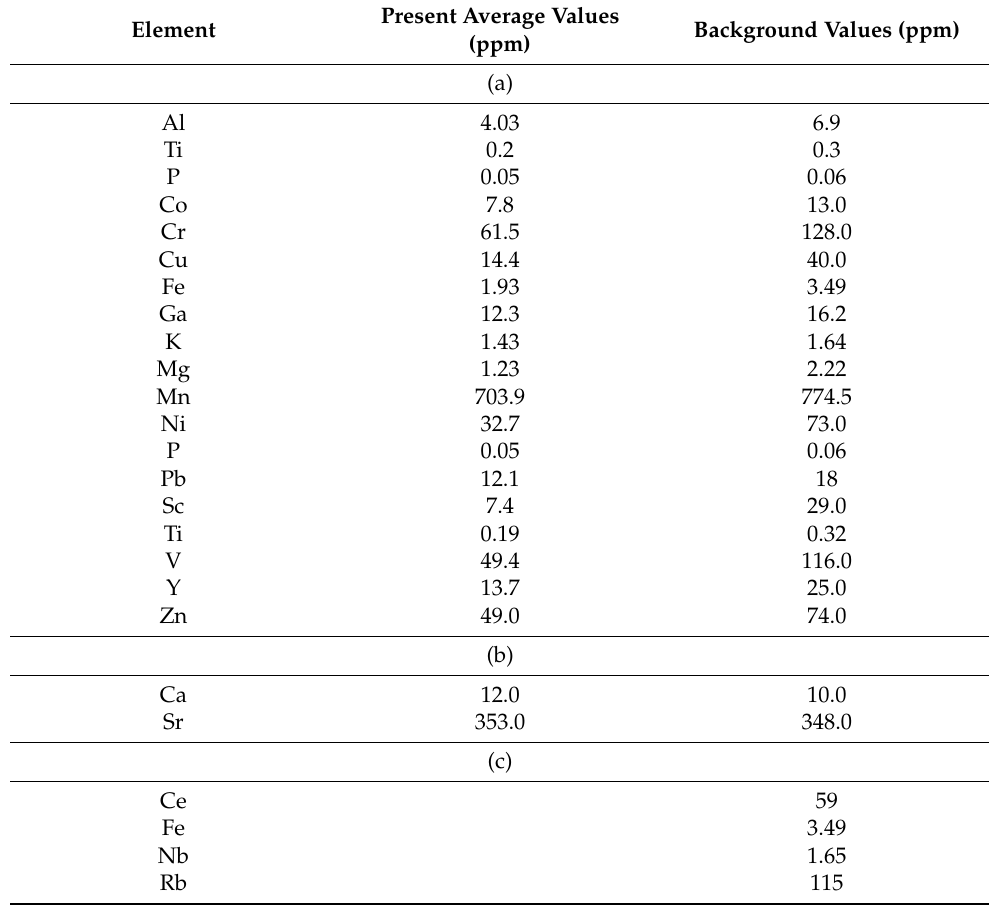
Table 5. Elements that decrease respect to the past (a); elements that increase respect to the past (b); elements for which only the background value is available